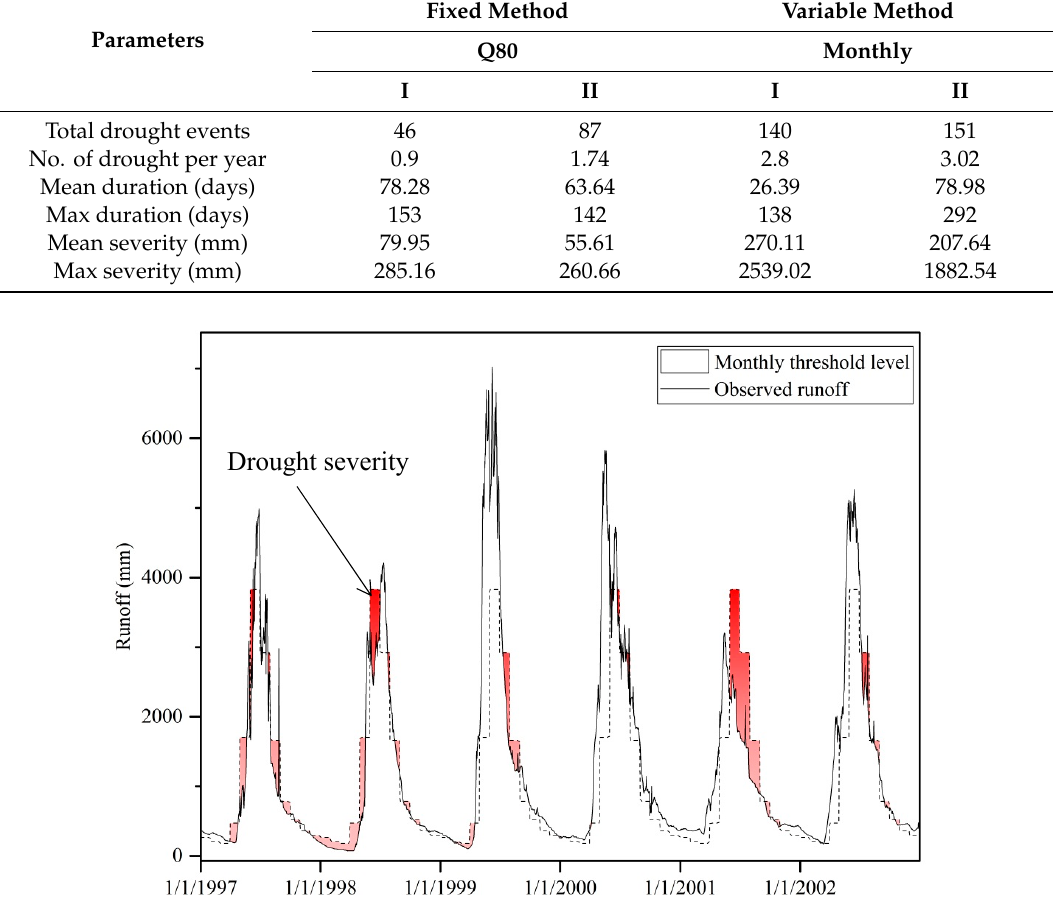
Figure 26. Example of drought analysis based on transient threshold levels for the Zone II. 3.6. Sensitivity of Hydrological Regime to Climate The runoff regime has been observed to be more consistent than the temperature regime, and there was a strong relationship between temperature and runoff in Zone I. This provides strong evidence that runoff varied in response to variations in temperature rather than precipitation. The hydrograph of Zone I also indicates the strength of the relationship between runoff and temperature, as shown in Figures 27 and 28. The snow began to melt earlier in this zone. The inter-annual